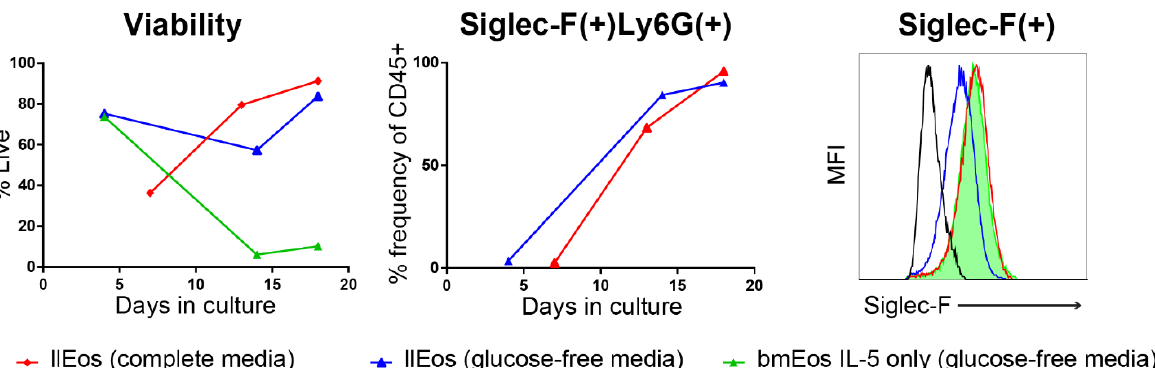
Figure 5. Glucose is not required for the maturation of llEos. Both llEos cultured in complete media (red) or glucose-free media (blue) are similarly viable. The ability to survive in glucose free conditions is specific to the llEos protocol, as bmEos cultured in IL-5 only protocol (green) rapidly declined in glucose-free media. However, glucose deficiency affects phenotypic development of llEos by reducing their cell surface expression of Siglec-F (measured on D13 of culture).